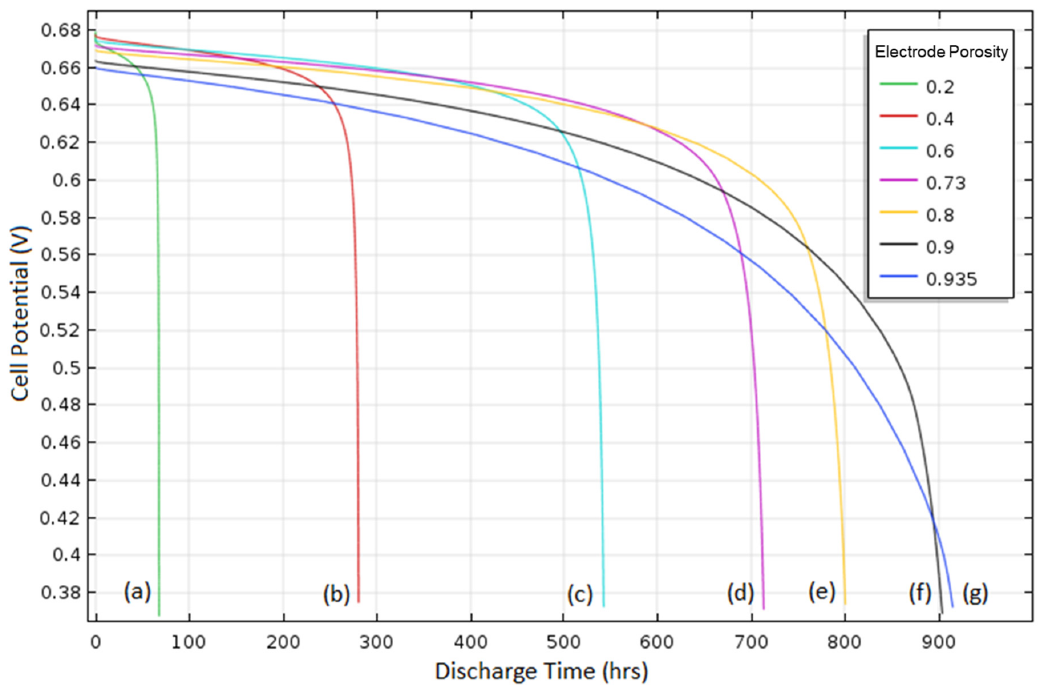
Figure 11. Discharge curves at 1 A/m 2 for initial porosities of a) 0.2, b) 0.4, c) 0.6, d) 0.73, e) 0.8, f) 0.9, and g) 0.935, with 0.5 O 2 solubility and 195 μ m cathode